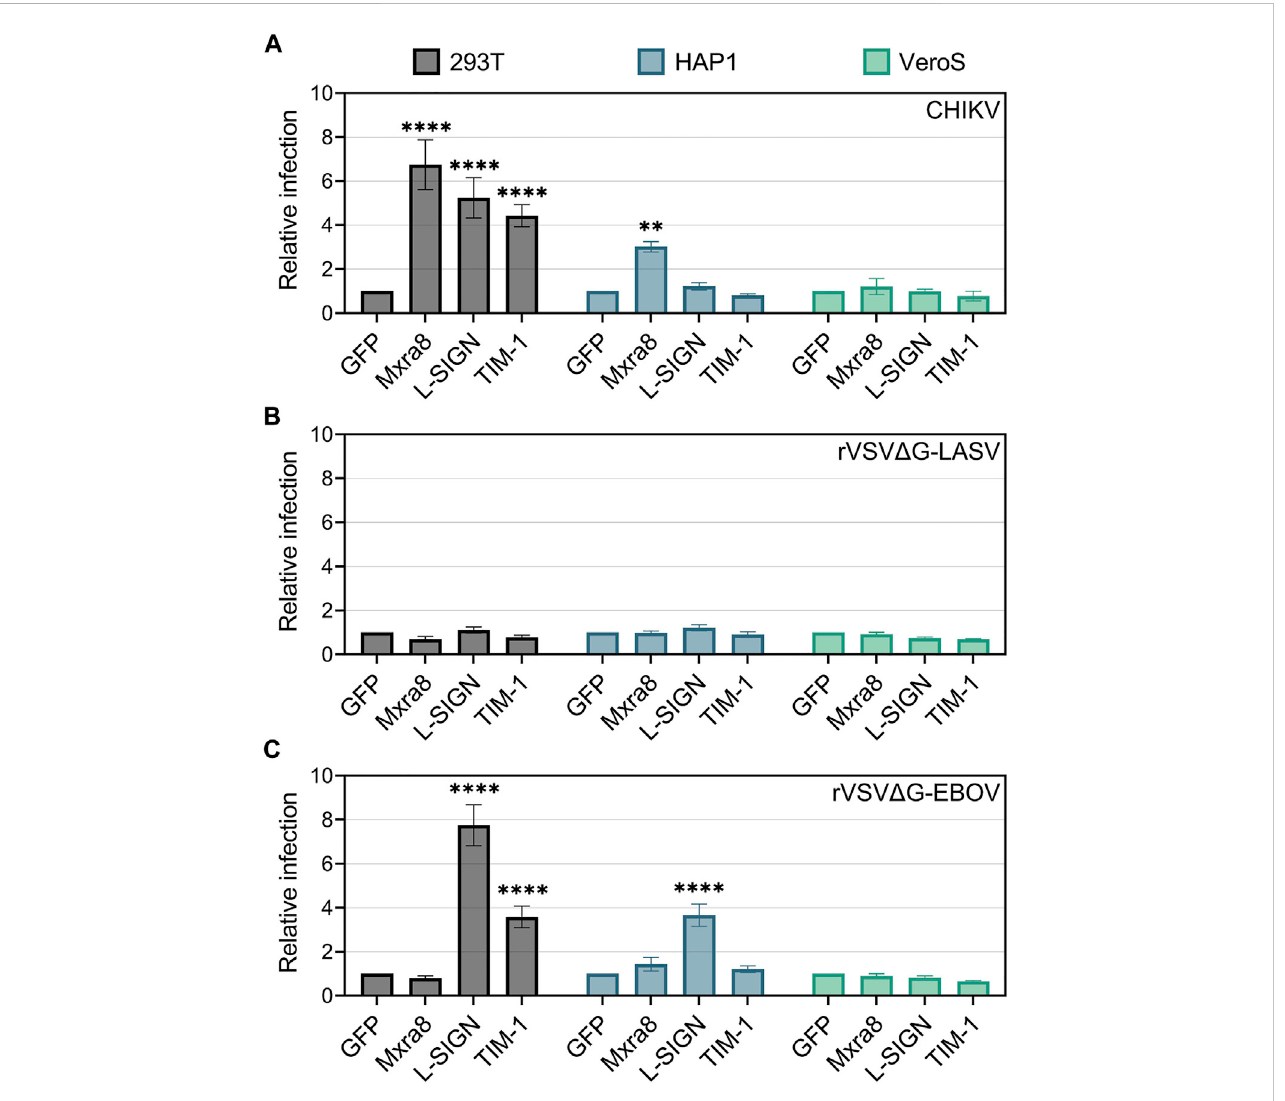
FIGURE 2 Mxra8, L-SIGN, and TIM-1 enhance CHIKV infection in 293T cells. 293T, HAP1, and VeroS cells were transfected with either TIM-1-GFP, Mxra8 and GFP, L-SIGNandGFP,orGFPalone.24 hpost-transfection,cellswereinoculatedwitheithermKate-expressing (A) CHIKVstrain181/c25, (B) recombinantvesicular stomatitis virus containing the Lassa virus glycoprotein (rVSV Δ G-LASV), or (C) rVSV containing the Ebola virus glycoprotein (rVSV Δ G-EBOV) for 1 h. 12 h following infection the cells were enumerated in a fl ow cytometer. Relative infection was calculated as the proportion of infected cells (mKate + ) among transfectedcells(GFP + )normalizedtoinfectionlevelsinaGFP-onlycontrol.Dataarepresentedasthemean±SEMfromthreeindependentexperiments.Data were compared with a two-way ANOVA with multiple comparisons, comparing row effects (receptors produced) to the GFP only control: **, p < .01; ****, p <